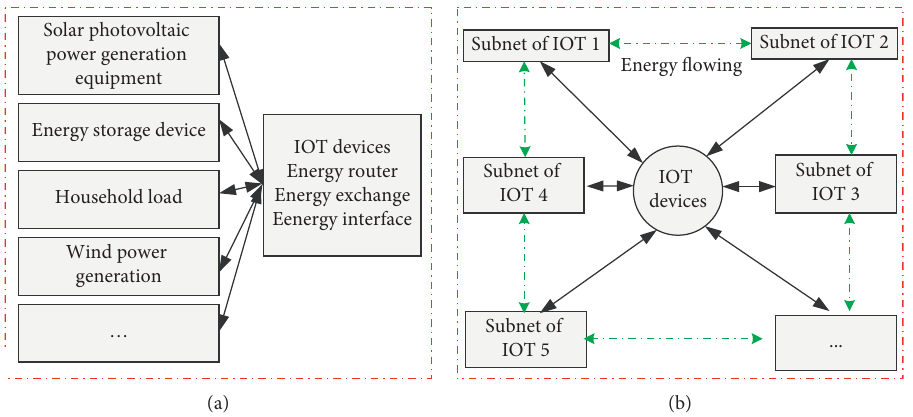
Figure 2: The schematic diagram of the BT-based IoT system. (a) Subnet of IoT. (b) The physical network of EI.